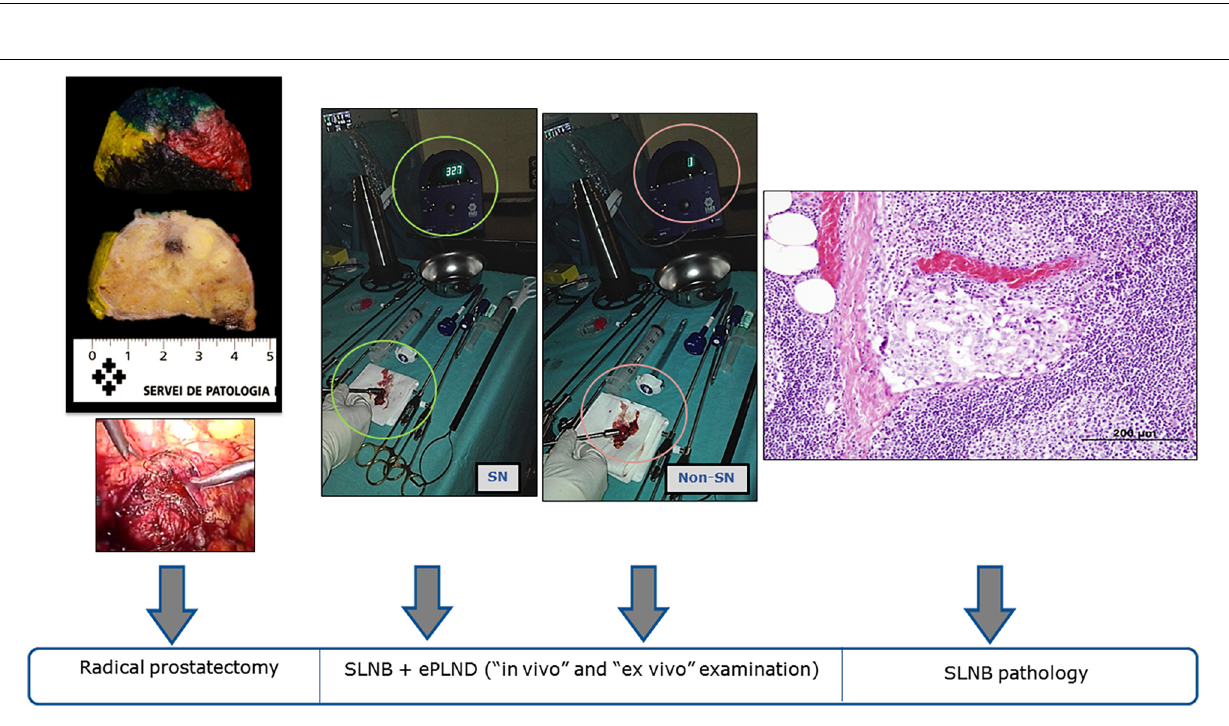
Frontiers in Medicine |